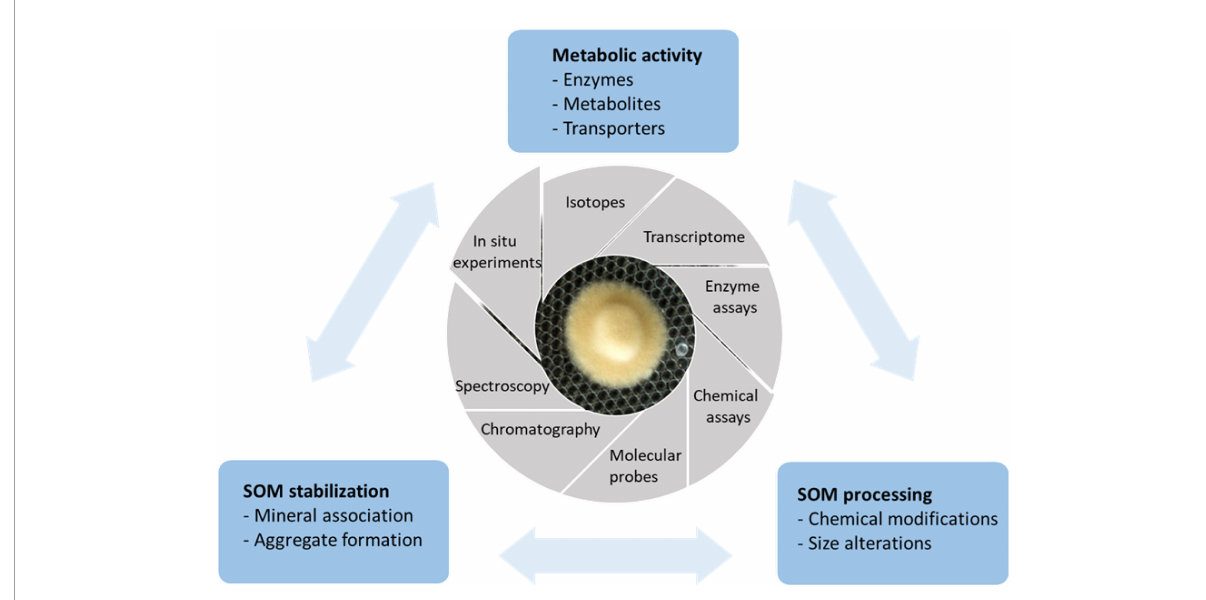
FIGURE1 Laboratory-scale model systems and multimethod approaches used in our research group to unravel the mechanisms for organic N acquisition in ectomycorrhizal (ECM) fungi and their consequences for soil C stabilization. Single species of ECM fungi are grown on a layer of glass beads immersed in liquid medium containing organic matter or specific compounds representing the major compound classes present in organic matter. Soil organic matter has been extracted with water from the organic soil layer of a Norway spruce stand. This layer contains a large part of the soil but can also contain significant proportions of mineral constituents (Keiluweit et al., 2012). The extracted fraction is commonly referred to as dissolved organic matter (DOM). DOM is believed to be the most bioavailable fraction of SOM, and it plays a key role in the formation of organic matter-mineral associations and molecular aggregates that enhance the stabilization of soil C (Bolan et al., 2011; Lehmann and Kleber, 2015). In certain experiments, N-sources and DOM have been coated to pure Fe(III) minerals including ferrihydrite and goethite, which are abundant in forest soils and exhibit differences with respect to surface properties and redox potential. The metabolic activity of the fungi, including the uptake, secretion of oxidative and hydrolytic enzymes and metabolites have been analyzed using isotope, transcriptome, enzyme assays, and various chemical analyses. Molecular probes (e.g., coumarin) have been used to measure the production of · OH radicals. In parallel, an array of different chromatographic and spectroscopic methods [e.g., NMR, infrared spectroscopy (IR), pyrolysis gas chromatography/mass spectrometry (Py-GC/MS), and X-ray absorption spectroscopy (XAS)] have been used to gain information on the structure, composition, and heterogeneity of SOM and its interactions with minerals. In order to perform more detailed studies on